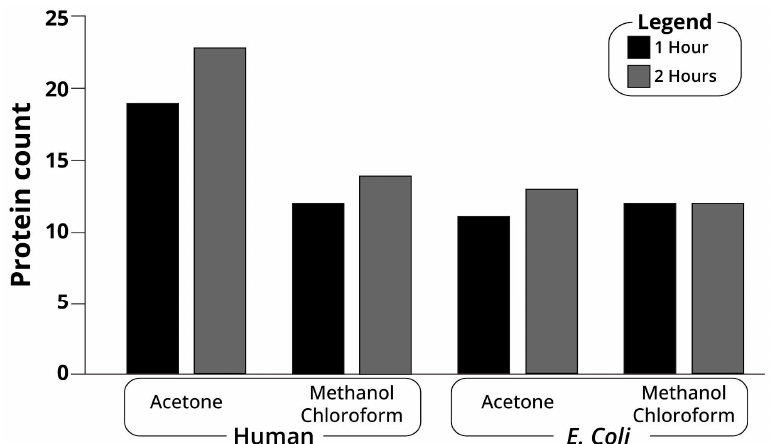
Figure 3. Comparison of the MS samples running time. A. 1 vs. 2 h run of E. Coli and human proteins after methanol ‐ chloroform and acetone precipitation. After setting the minimal peptide count to three, methanol ‐ chloroform precipitation resulted in twelve identified E. Coli proteins for both the 1 and 2 h run gradients (Figure 3). By contrast, after acetone precipitation, 13 proteins were identified in the 2 h run, com ‐ pared to 11 proteins after the 1 h run (Figure 3). With no dramatic differences at the protein level, we analyzed these data at the peptide level. When examining the distribution of the peptide count following methanol ‐ chloroform precipitation, only two proteins were iden ‐ tified with the same number of peptides in both runs, five proteins had more peptides in the 2 h run, one protein had more peptides in the 1 h run, two proteins were present only in the 2 h run, and four proteins were present only in the 1 h run (Figure 4a–d). After acetone precipitation, three proteins were identified with the same number of peptides in both runs, four proteins had more peptides in the 2 h run, two proteins had more peptides in the 1 h run, four proteins were present only in the 2 h run and two proteins were present only in the 1 h run (Figure 4a–d). Overall, these data suggest that a 2 h gradient typically identifies slightly more proteins and peptides.